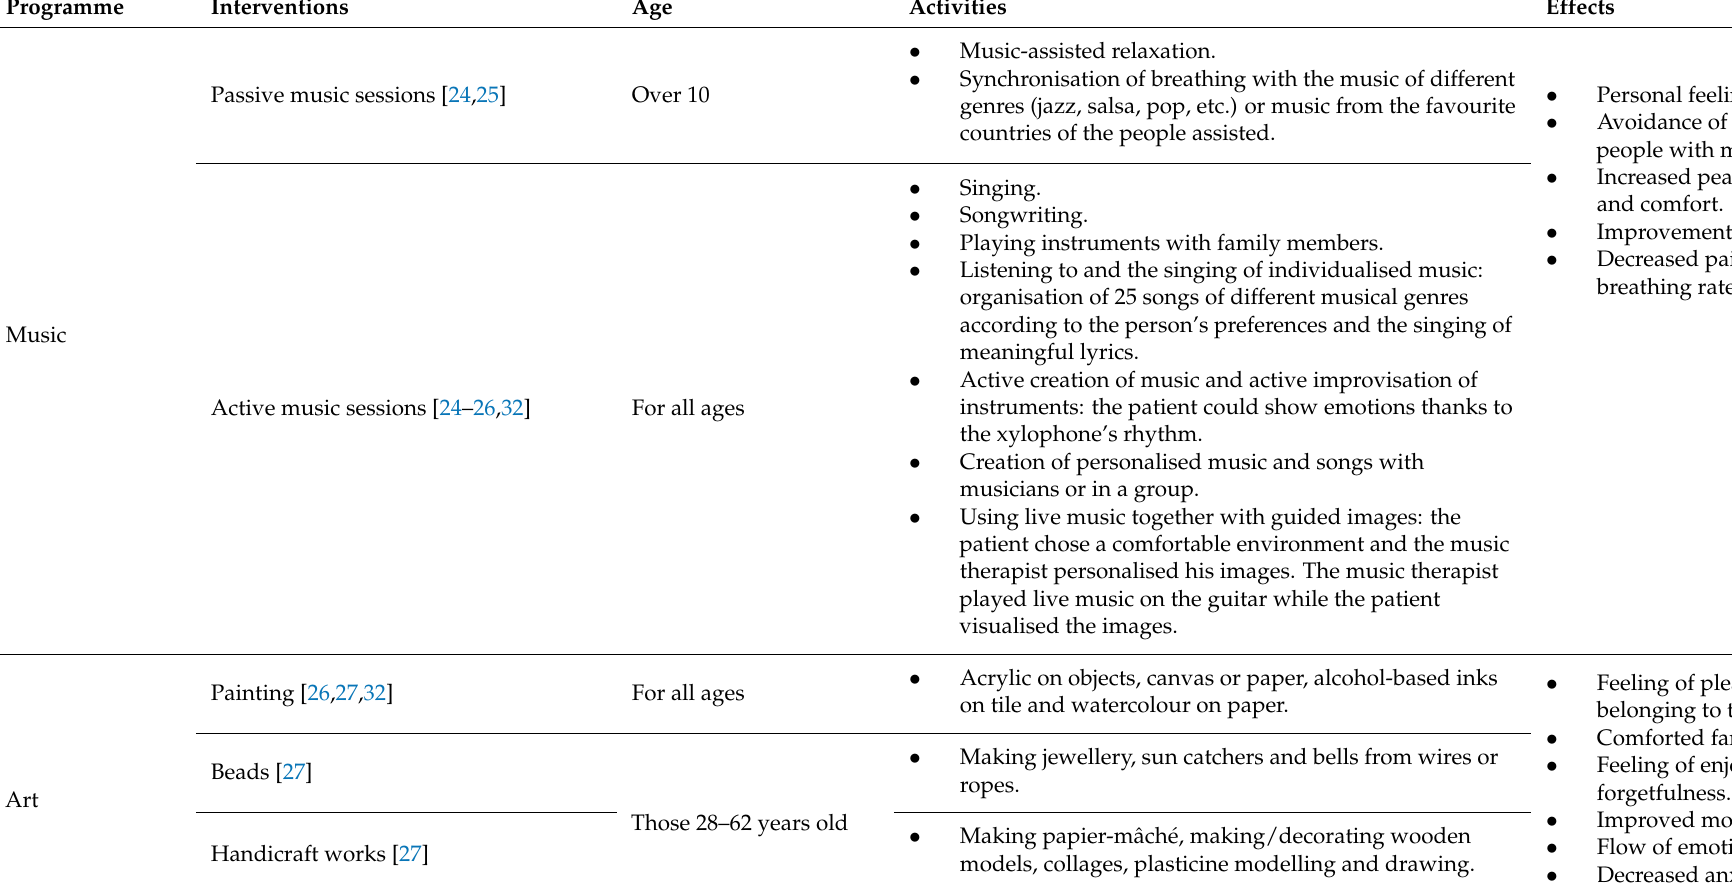
Table 3. Summary of the relationship between leisure programmes, interventions and activities and their